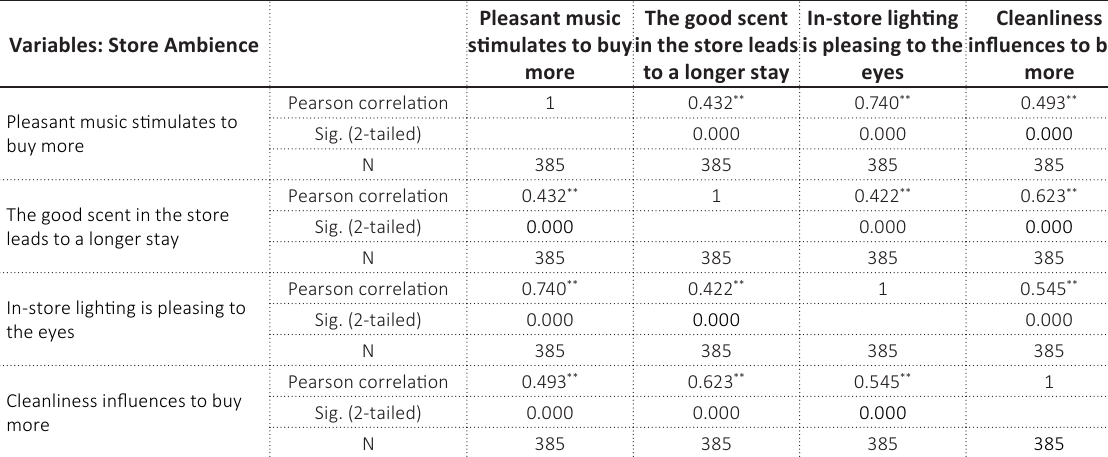
Table 3. Correlation between the variables of store ambiance